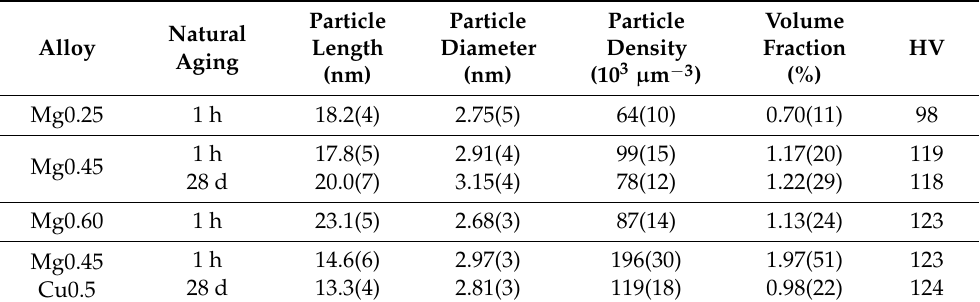
Table 4. Quantified average precipitate parameters of the 6 conditions shown in Figure 6 Parentheses give error estimations of the last digits. Vickers hardness (HV) is included for reference.